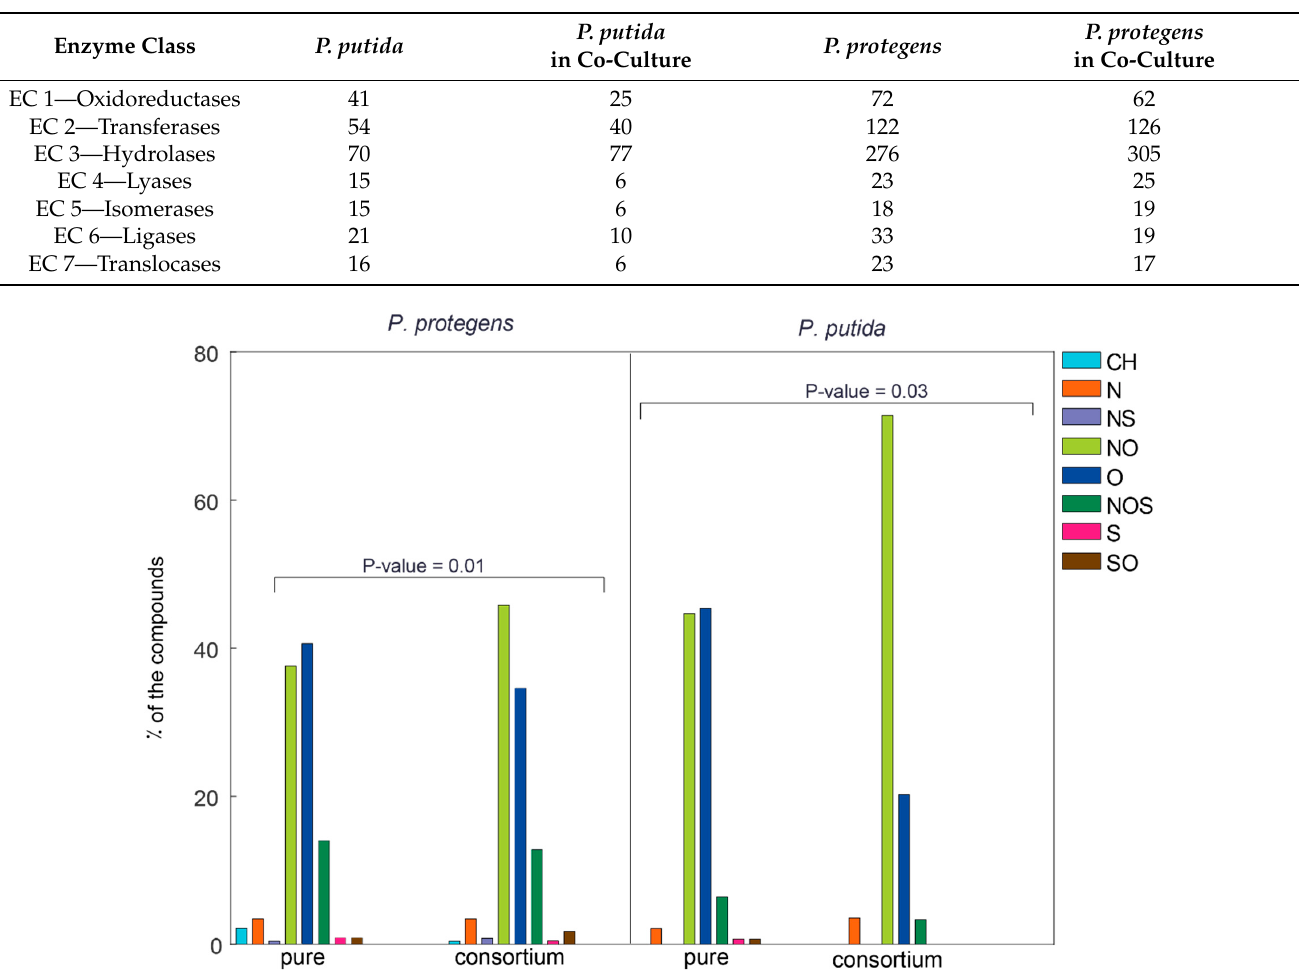
Figure 4. Heteroatomic classification of the substrates of the enzymes expressed by P. protegens and P. putida . NAFCs are classified as CH, N n , N n S s , N n O o , O o , N n O o S s , S s and S s O o based on their heteroatomic composition. These groups have been represented as CH, N, NS, NO, O, NOS, S and SO, respectively, in the legend. The metabolic networks of P. protegens and P. putida in the pure and co-cultures are significantly different. The p-values for these differences were calculated using the chi-squared test on the distribution of compounds amongst the classes. Additionally, the code used to generate this plot is published in the first Jupyter notebook that has been included in the ESI package.